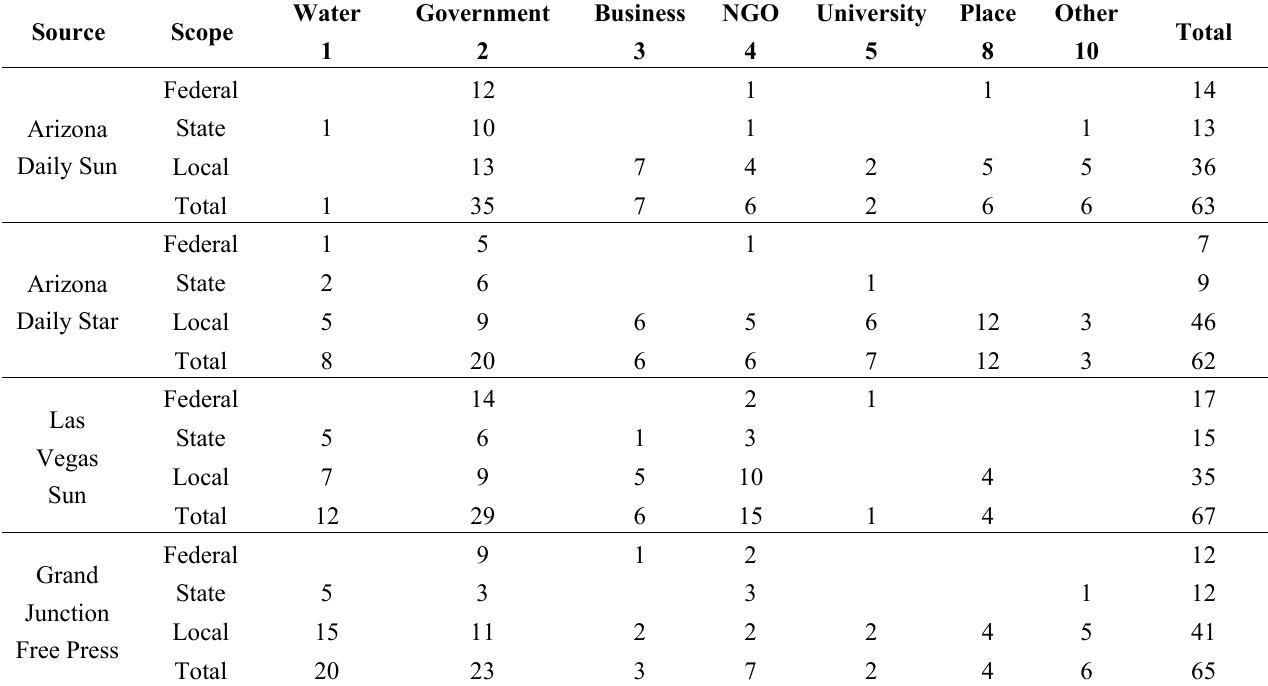
Table 9. Counts of entities, by category and level, from Step 2